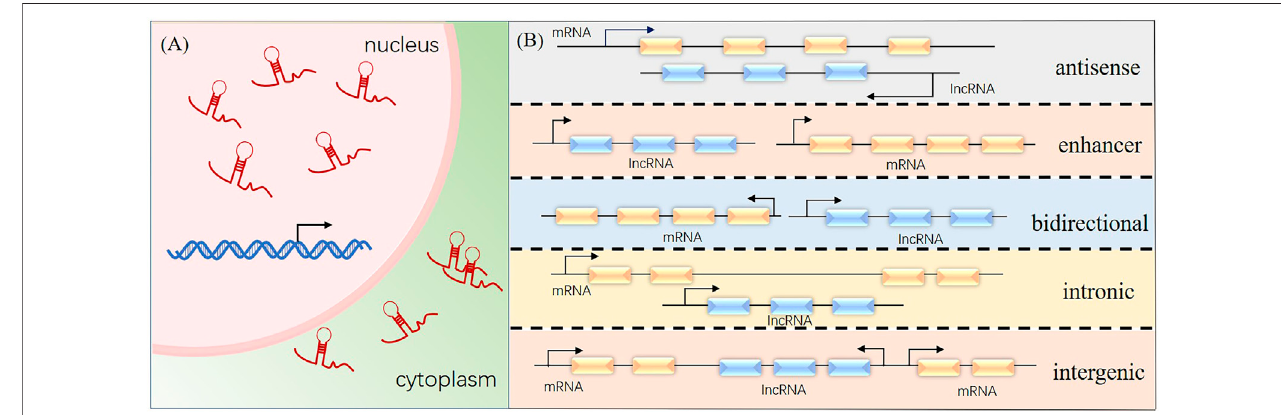
FIGURE 1 | Cellular localization and classi fi cation of long non-coding RNAs (lncRNA). (A) Cellular distribution of lncRNAs. (B) Positions of lncRNAs in the genome relative to the target protein-coding